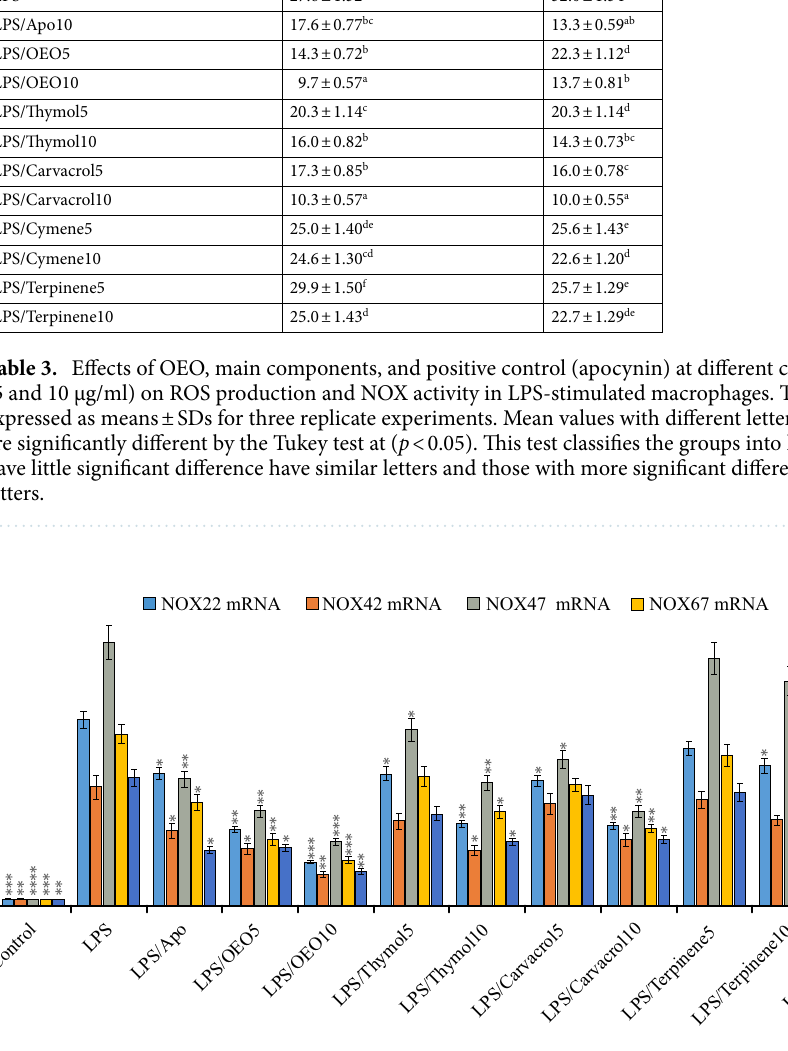
Figure 1. Effects of OEO, main components, and positive control (apocynin) on the NOX mRNA expression in LPS-stimulated macrophages. Mean values are significantly different by Tukey test at *p < 0.05, **p < 0.01, ***p < 0.001 and ****p < 0.0001 versus LPS